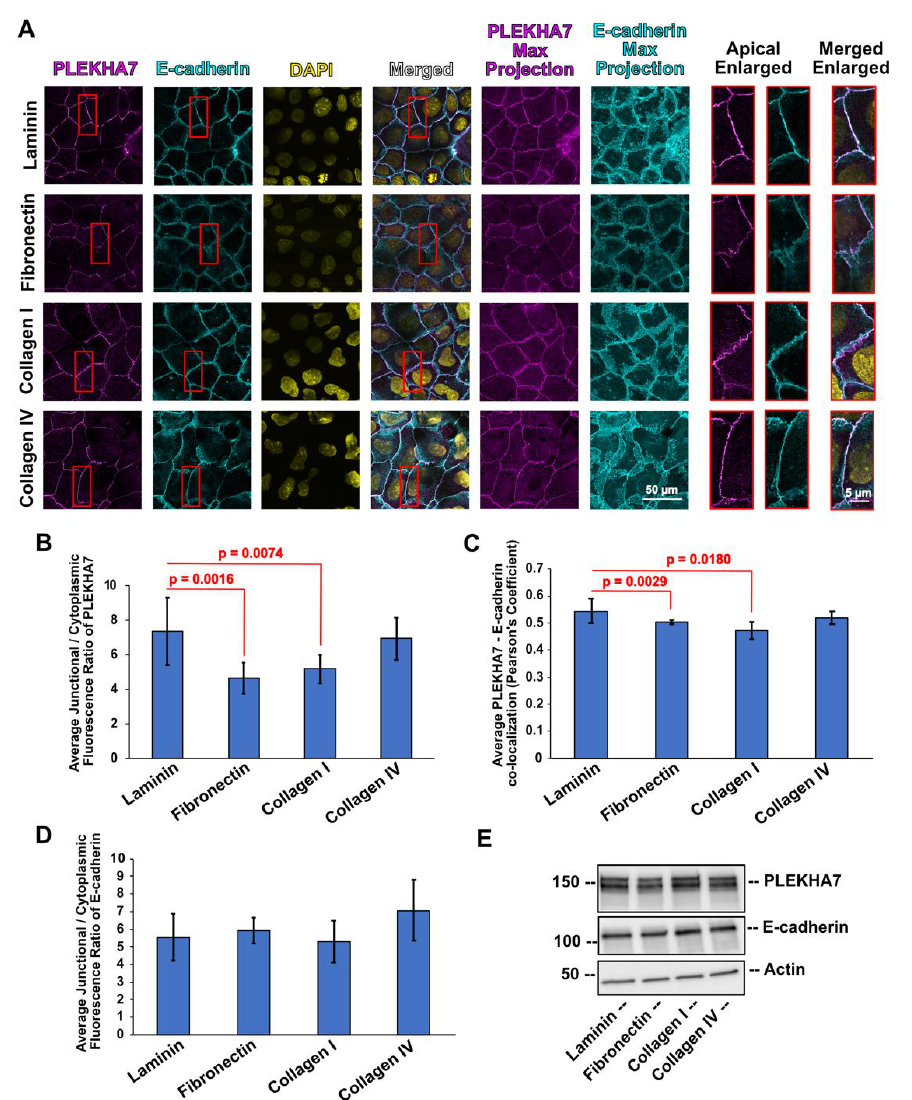
Figure 2. ( A ) Representative images of Caco2 colon epithelial cells plated on laminin, fibronectin, collagen I, and collagen IV, stained by immunofluorescence for PLEKHA7 (magenta) and E-cadherin (cyan). Nuclei were stained using DAPI (yellow). ( B ) Average junctional/cytoplasmic fluorescence intensity ratios of PLEKHA7 from cells plated on different ECM substrates. ( C ) Average co-localization of PLEKHA7 with E-cadherin fluorescence from cells plated on different ECM substrates. ( D ) Average junctional/cytoplasmic fluorescence intensity ratio of E-cadherin from cells plated on different ECM substrates. ( E ) Western blot from Caco2 cells plated on different ECM substrates blotted for PLEKHA7 and E-cadherin; Actin is the loading control. Data were analyzed using a student t -test, where p < 0.05 and n = 27 or n = 12 ≤ n ≤ 30 for ( C ) (see also Methods, Section 2.5). Selected insets indicated in red boxes are shown enlarged on the right.